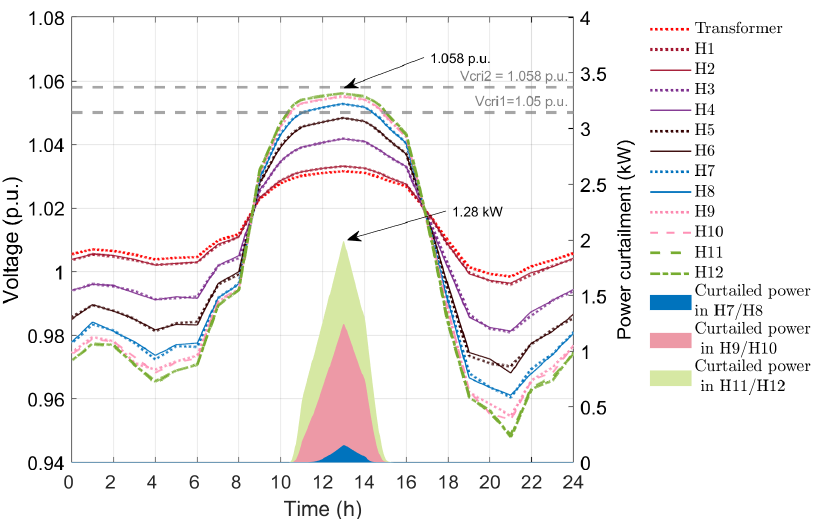
Figure 13. Voltage profile of twelve houses (House 1 to House 12) and curtailed power in quadratic droop-based APC method using ADP.